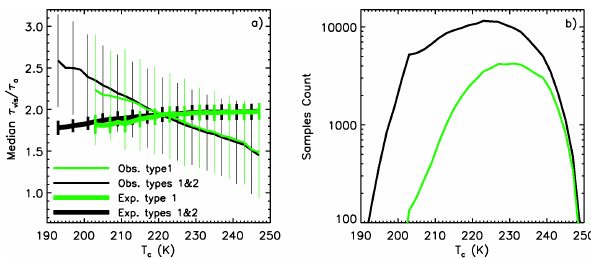
Figure 8. (a) Median observed (thin lines) and expected (thick lines) τ vis / τ a ratio ± standard deviation and (b) associated samples count against temperature T c for type 1 clouds (green, measured R BG ) and combined type 1 and type 2 clouds (black). Same data set as in Fig.